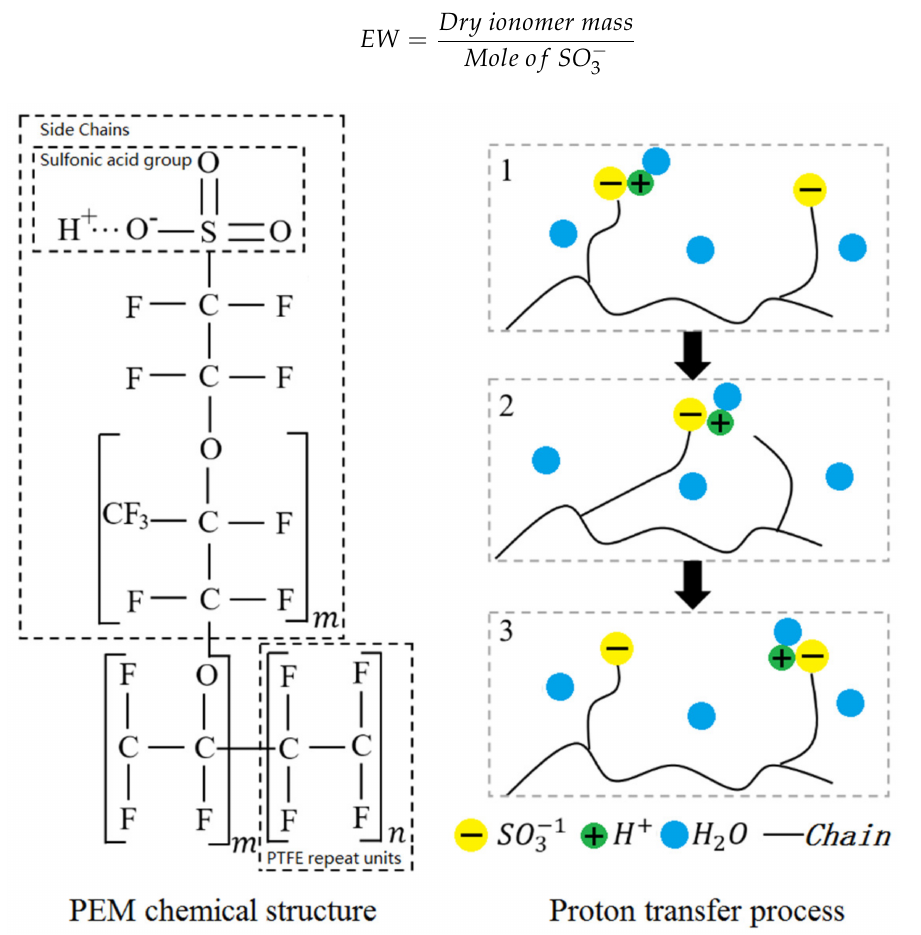
Figure 3. Schematic of chemical structure for Nafion and proton